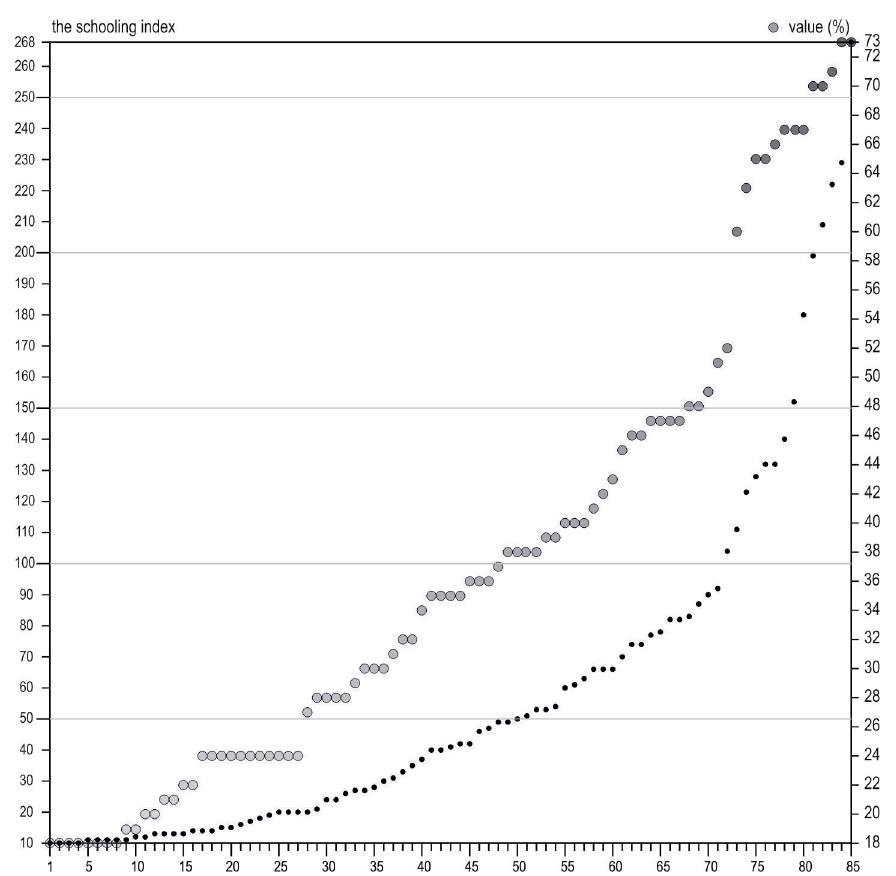
Fig. 5. Statistical data and value (shading). The engraver’s 37 steps of shading are visible